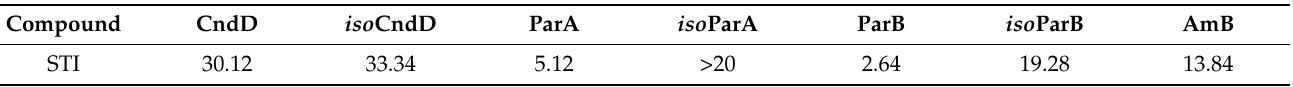
Table 4. Selective toxicity indexes (STIs) of Candicidin D (CndD), Partricin A (ParA), Partricin B (ParB), their all-trans isomers iso CndD, iso ParA, iso ParB and Amphotericin B (AmB). STI = EH 50 /MIC against C. albicans in RPMI-1640 medium.